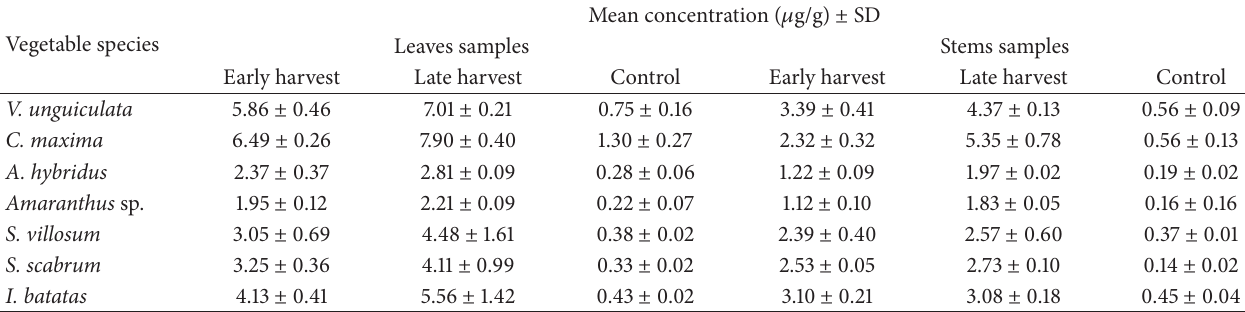
Table 2: Selenium concentration ( 𝜇 g/g) in vegetable samples.